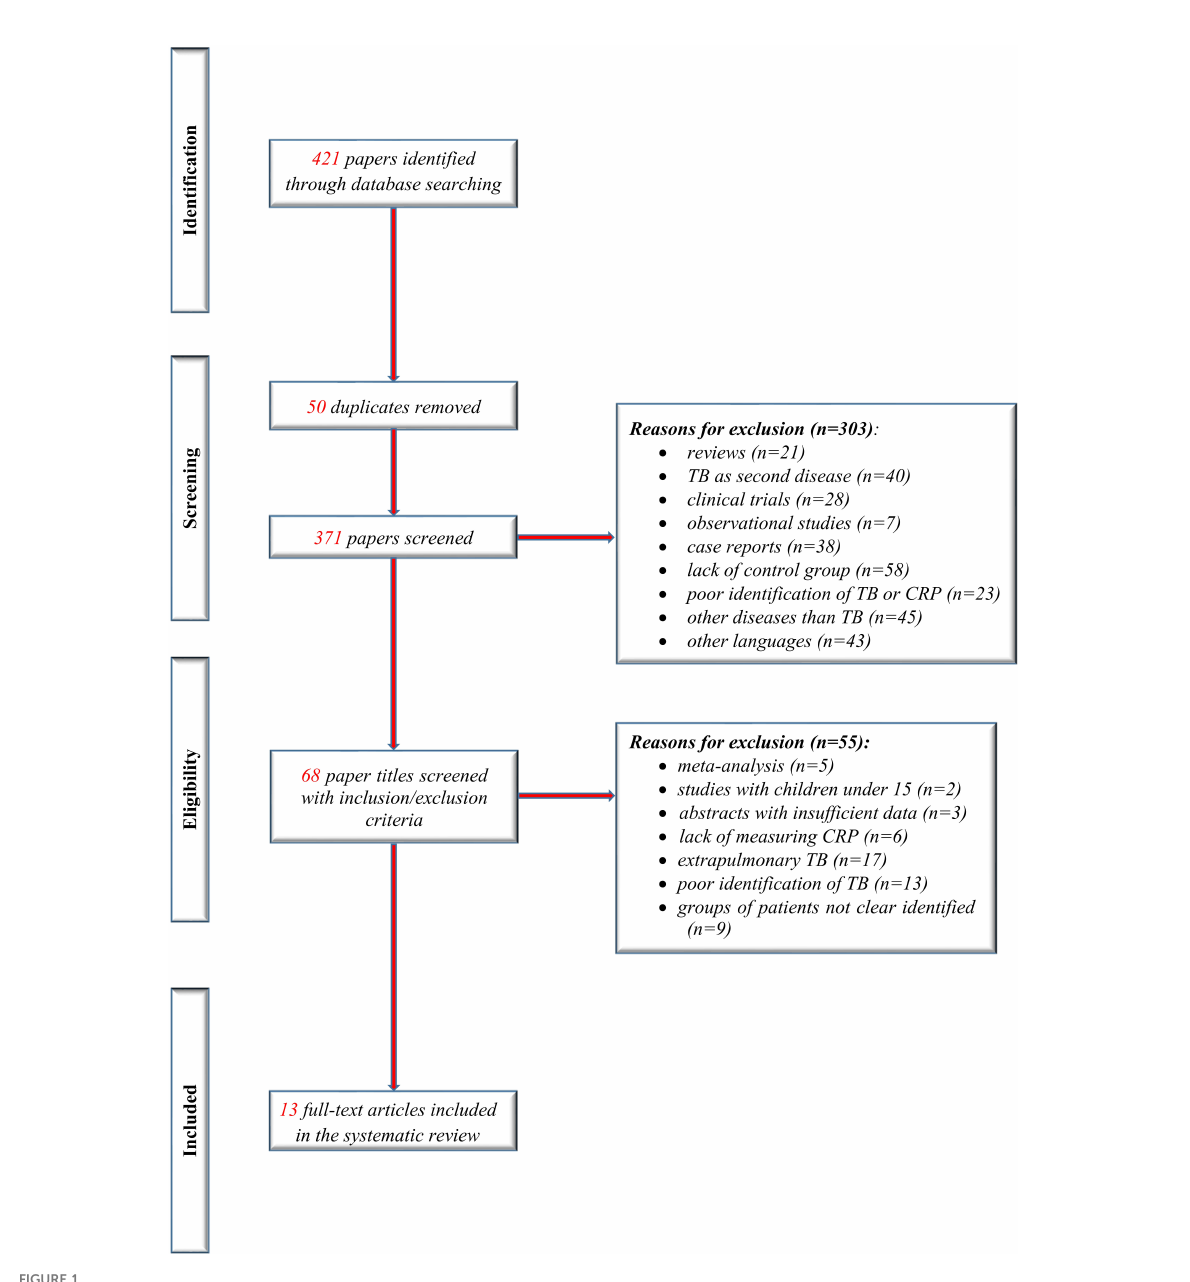
FIGURE 1 Study fl ow PRISMA